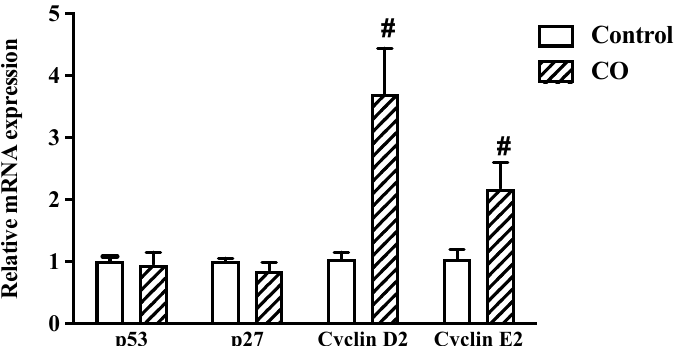
Figure 6. Effects of CO on cell-cycle regulators. Cells were treated with 2% CO or 10 µM CX with and without LPS for 24 h. mRNA expression of cell-cycle regulators was examined by real-time PCR. Values displayed are mean ± S.E.M ( n = 5), # p < 0.05 vs. LPS.